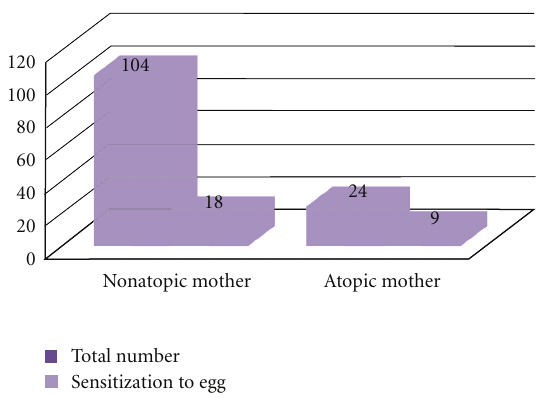
Figure 5: Relationship between maternal allergy and sensitization to egg of infants at the age of 12 months. Total numbers of infants and the numbers of infants sensitized to egg in each group are indi- cated.